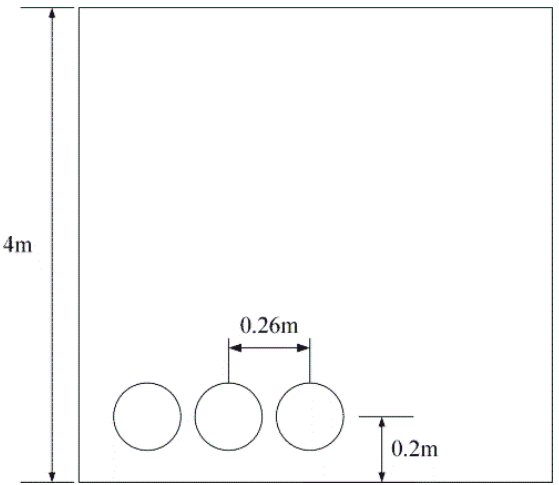
Figure 9. Laying configuration of the 110 kV cable line.